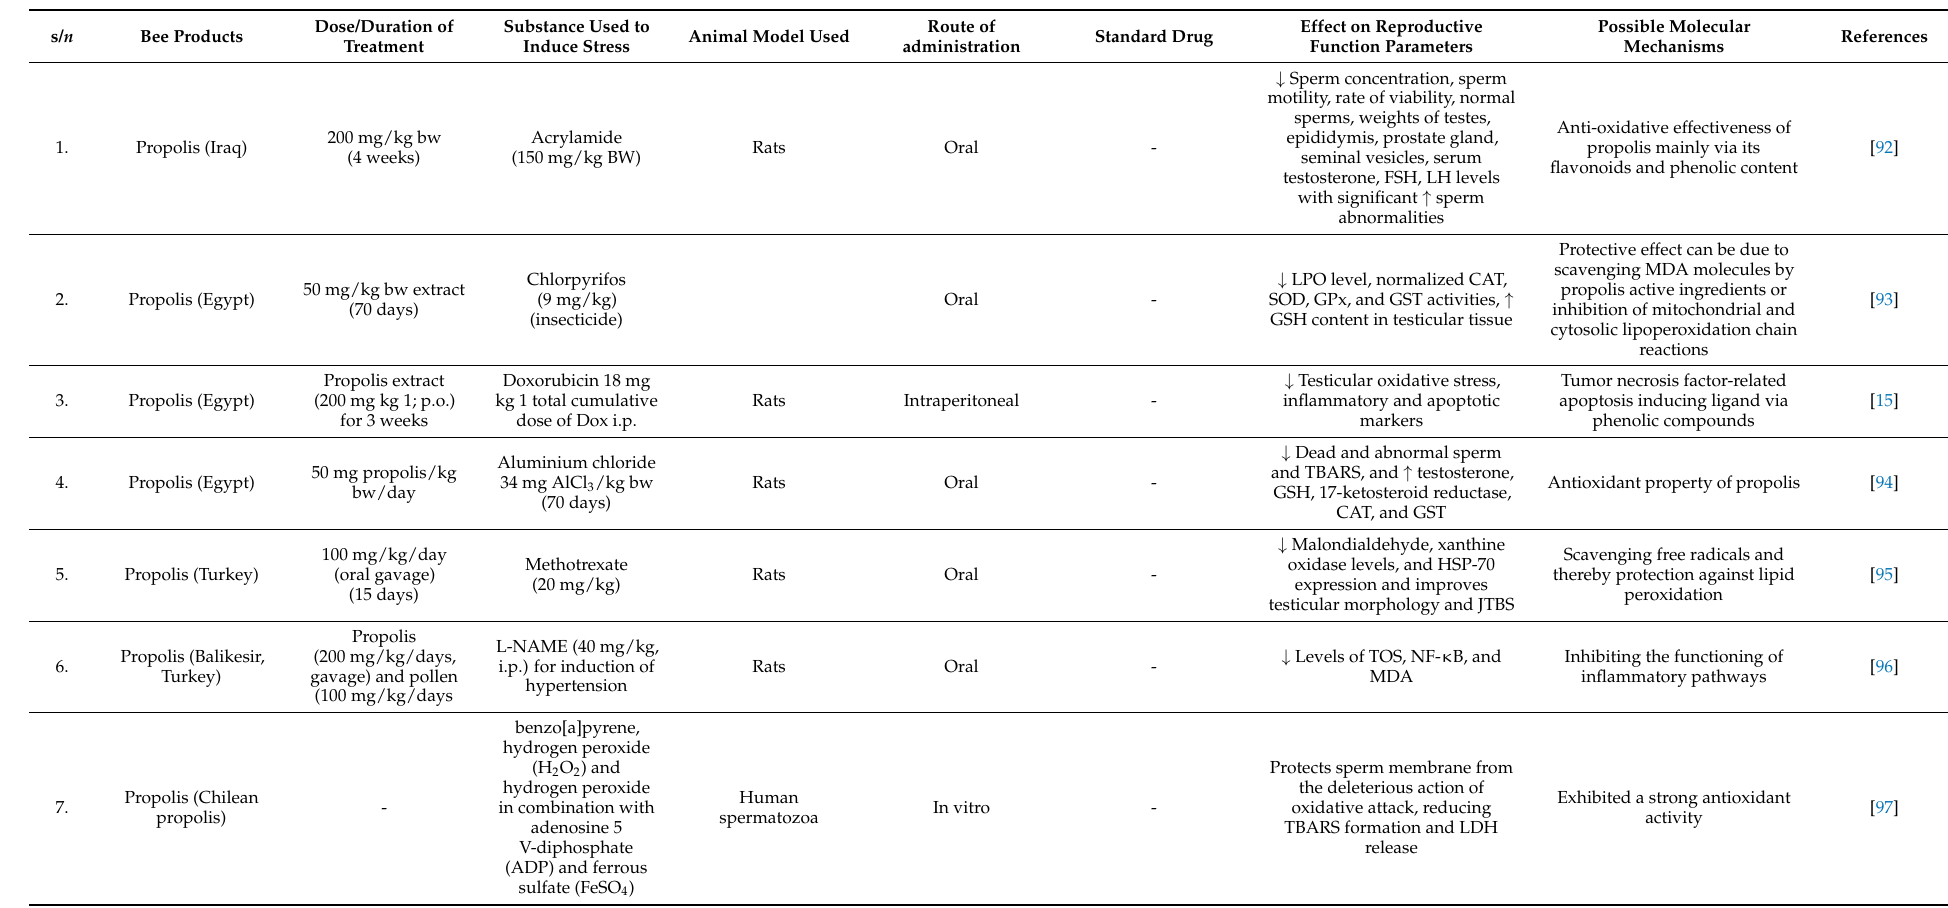
Table 4. Effects of propolis on male reproductive